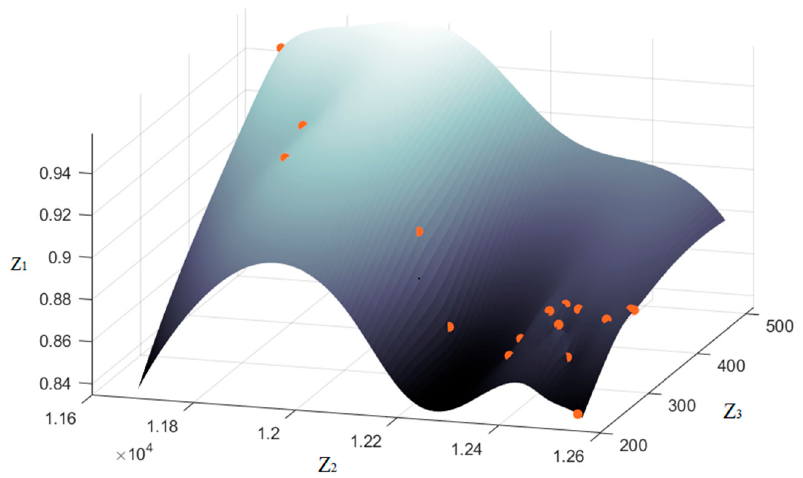
Figure 4. Pareto front solution.